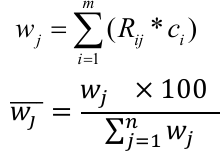
The QFD matrix for supplier selection Customer Requirements CReqs